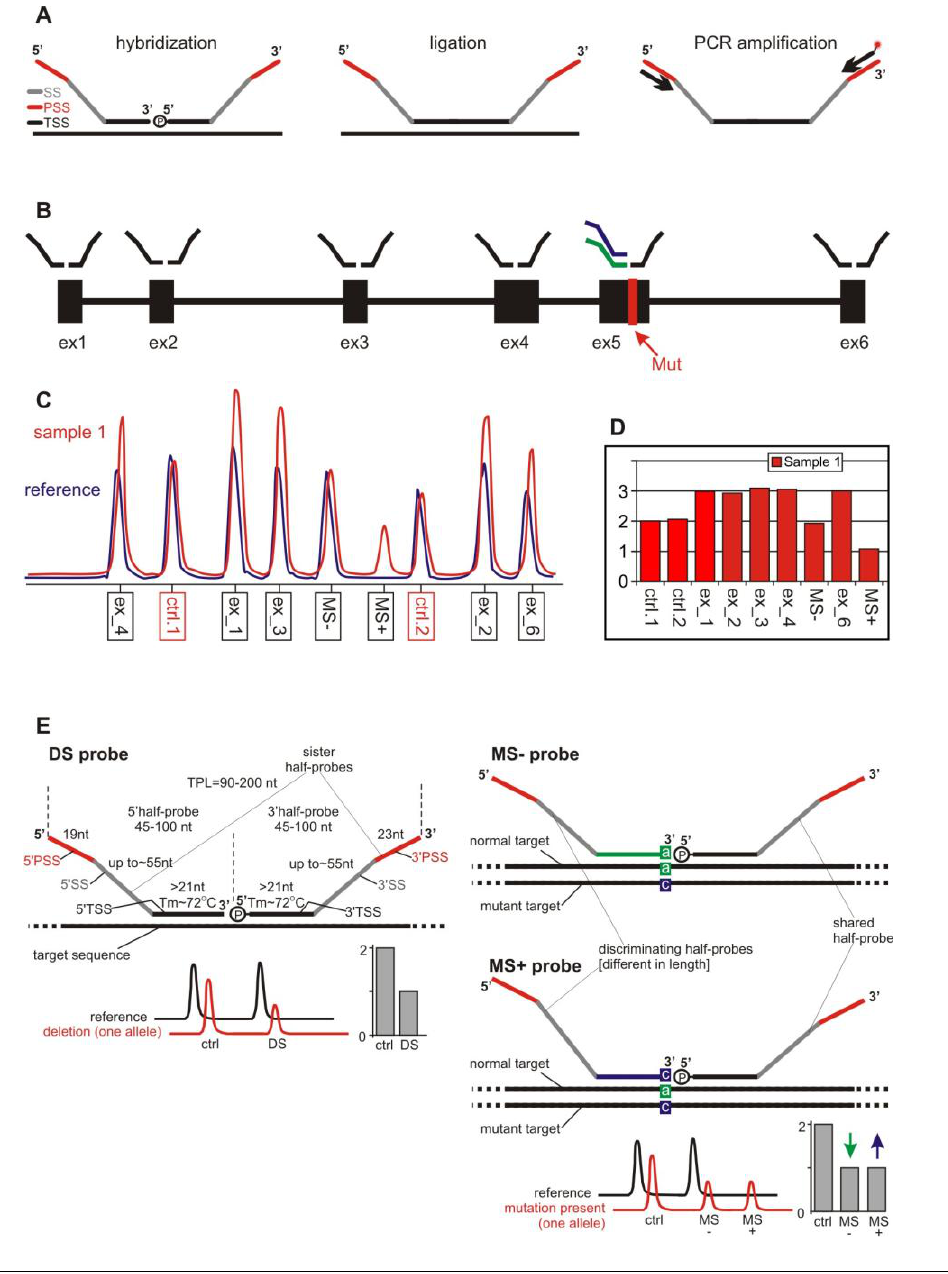
FIGURE 1. The principle of MLPA analysis for simultaneous identification of CNV and small mutations. (A) Three subsequent steps in the MLPA reaction (from left to right): hybridization of sister half-probes to the target sequence, ligation of correctly hybridized probes, and PCR amplification of ligated probes with universal primers. Primer-specific sequences (PSSs), stuffer sequences (SSs), and target-specific sequences (TSSs) are indicated in red, gray, and black, respectively. (B) Structure of a hypothetical model gene with the locations of MLPA probes (above). The probe located in exon 5 has two alternative 5’ half-probes: one (MS-) specific for normal (green) and the other (MS+) specific for mutant (blue) sequence. The alternative 5’ half-probes are different in length. (C) Overlapped hypothetical electropherograms of subject (red) and reference (blue) samples. Probe IDs are indicated below the electropherogram. (D) Bar graph showing relative copy number values calculated for each probe. Increased signal from all exonic probes (ex_1 to ex_6) indicates entire gene duplication. Relatively low signal from probe MS- located in exon 5 indicates the presence of a small mutation that is additionally confirmed by the appearance of a signal from the mutation- specific (MS+) probe. (E) Characteristics of the three types of MLPA probes; (left-hand side) copy number–sensitive (DS) probe, (above, right- hand side) small-size mutation–sensitive, negative (MS-) probe, and (below, right-hand side) small-size mutation–sensitive, positive (MS+) probe. In each upper panel, a schematic representation of an MLPA probe hybridized to its target sequence is shown. PSSs, SSs, and TSSs are indicated and marked as in panel A. TSSs specific for normal and mutant sequences are indicated in green and blue, respectively. In panels DS and MS (below), a schematic electropherogram of the analyzed (red line) and reference (black line) sample is shown. The results of copy number analysis presented in the form of a bar plot are shown below on the right-hand